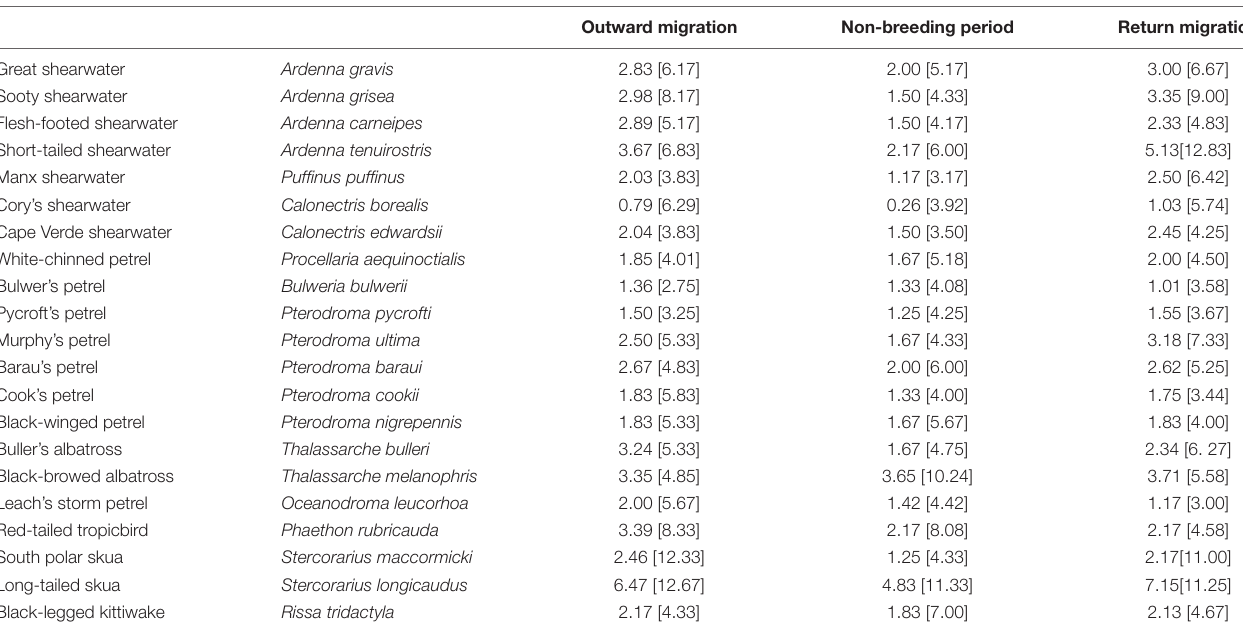
Values are the medians across individuals of individual 95% quantile, with maximum values across individuals of 95% quantile between square brackets. Species ordered according to phylogenetic proximity. See Figure 1 for the results of statistical tests contrasting flight bout durations between migrations and the rest of the non-breeding period.